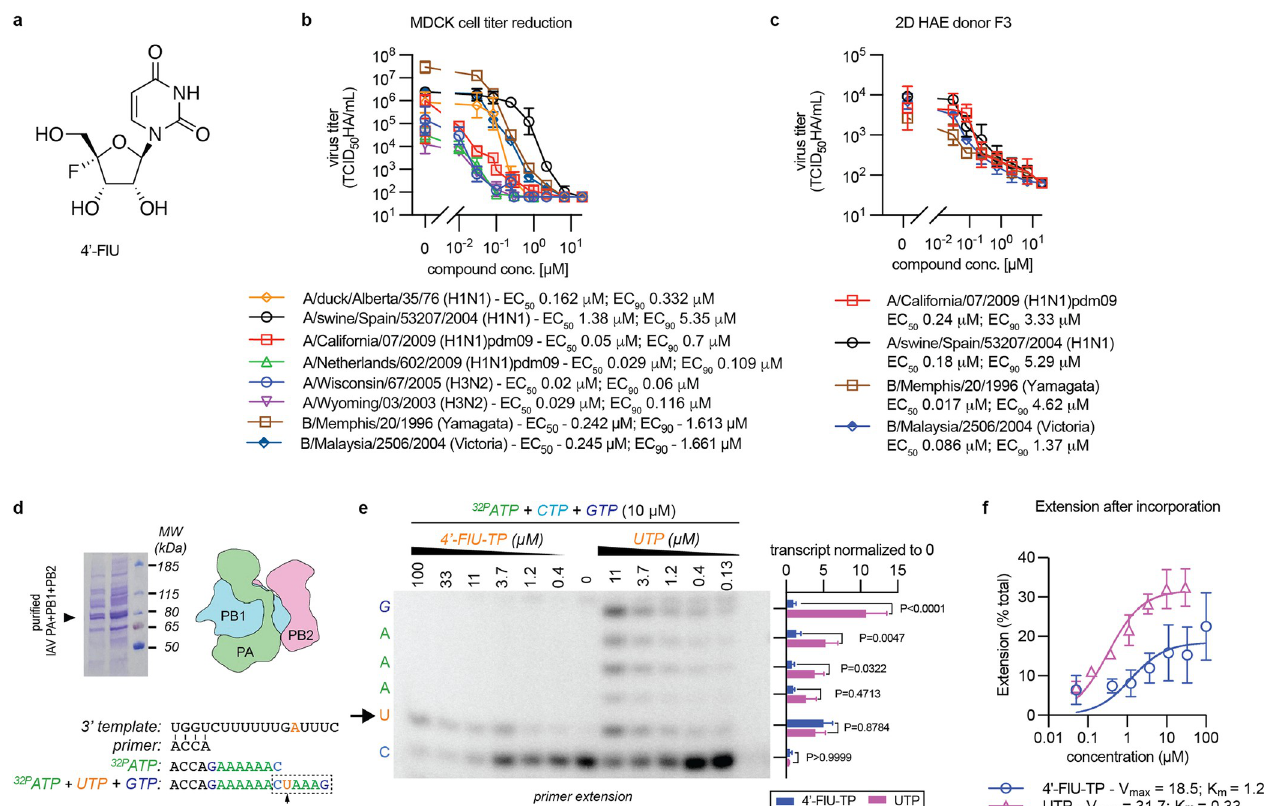
Fig 1. In vitro potency and MOA of 4’-FlU against influenza viruses. a) Structure of 4’-FlU. b) Dose-response assay of 4’-FlU on MDCK cells. Cells were infected with different subtype IAVs or different IBV isolates. c) 4’-FlU antiviral activity in 2D HAE cultures. Dose-response assays of 4’-FlU against A/ California/07/2009 (H1N1), A/swine/Spain/53207/2004 (H1N1), A/Wisconsin/67/2005 (H3N2), B/Memphis/20/1996 (Yamagata lineage), and B/Malaysia/ 2506/2004 (Victoria lineage) on undifferentiated HAEs derived from a healthy female donor. Lines in (b-c) intersect, and symbols show, geometric means ± SD (n = 3); EC 50 and EC 90 values based on 4-parameter variable slope regression modeling are given. d) Coomassie blue staining of purified recombinant IAV RdRP proteins after gel electrophoresis and RNA template sequences used in primer extension assays. e) In vitro RdRP assay in the presence of 32 P-ATP, CTP, GTP, and UTP or 4’-FlU-TP as indicated. Representative autoradiogram showing the sequence section highlighted by dashed box in (d); the first incorporation of UTP or 4’-FlU-TP is after position i = 8 of the amplicon (arrow). The sequence of the amplicon and results of phosphoimager-quantitation of relative signal intensities observed in the presence of 11 μ M UTP or 4’-FlU-TP are specified to the left and right of the autoradiogram, respectively. Quantitation graph shows mean values of independent experiments (n = 3) ± SD; analysis with 1-way ANOVA with Dunnett’s post hoc test; P values are shown in the graph. Uncropped autoradiogram and replicates are provided in (S2 Fig). F) Kinetic analysis of 4’-FlU-TP and UTP incorporation into the amplicon shown in (e) and (S2 Fig). Lines represent non-linear regression kinetics with Michaelis-Menten model, K m and V max are shown, error bars represent 95% CI.